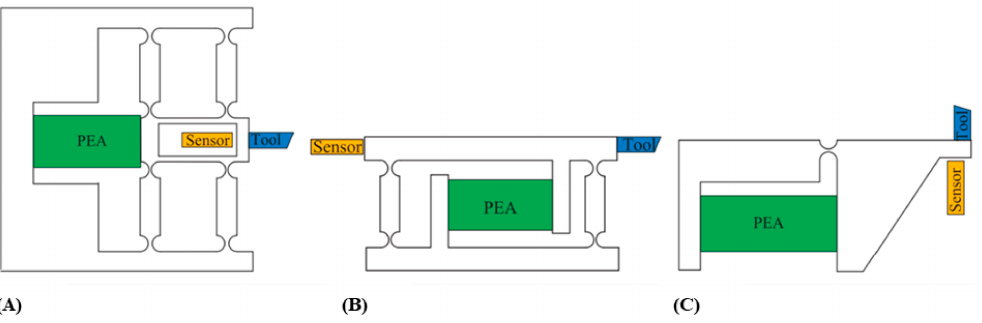
Figure 9. Common actuator, sensor (optional) and tool layouts for CM-based FTSs [69]. ( A ) Collinear layout; ( B ) Parallel-offset layout; ( C ) Non-parallel-offset